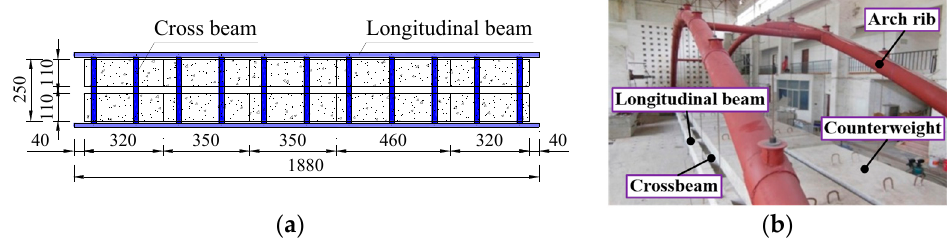
Figure 7. Schematic representation of the counterweight block load: ( a ) counterweight load (unit: cm); ( b ) counterweight stack on site.